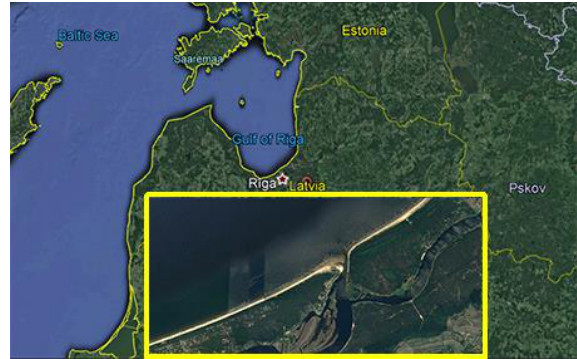
Figure 1. The study area.